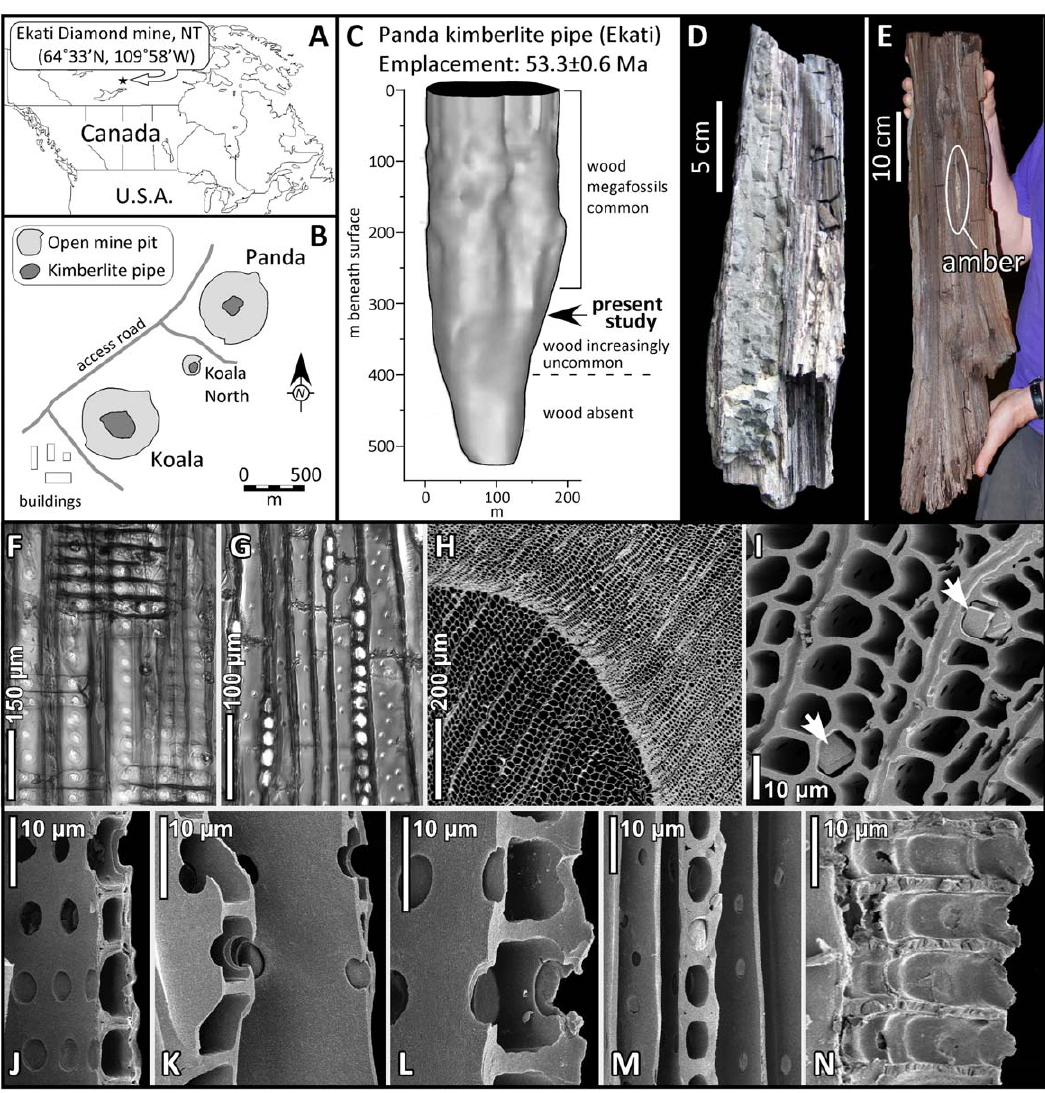
Figure 1. Study site and fossil wood from the Panda kimberlite pipe. A. Location of the Ekati diamond mine. B. Situation of the Panda kimberlite in relation to other pipes that comprise the property. C. Morphology of the Panda kimberlite pipe [8] and occurrence of wood. D. Fossil wood encrusted in olivine-rich volcaniclastic kimberlite. E. Photograph of the specimen characterized in this study. The wood was split when removed from the ore, revealing a sliver of opaque amber (9.5 cm long by 0.5 cm wide) in the xylem. F. RLS in transmitted light showing uniseriate and biseriate bordered pits and cross-fields. G. TLS showing rays stacked 3–26 cells high. H. SEM (TS) of ring boundary with earlywood (left) and latewood (right). I. Close-up of tracheids in TS and calcite crystals within cells (arrows). J. Cross-section of ray with cross-field pits. K and L. Close-ups of cross-field pits. M. TLS close-up of rays. N. Radial longitudinal section showing four contiguous rows of ray parenchyma cells with smooth end walls and no separation between the individual rows of